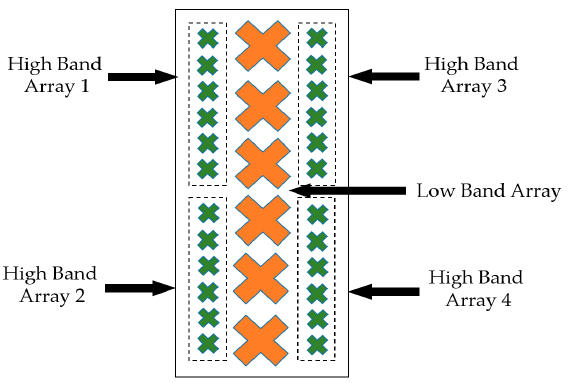
Figure 4. Low band to high band 1:4 antenna array configuration.